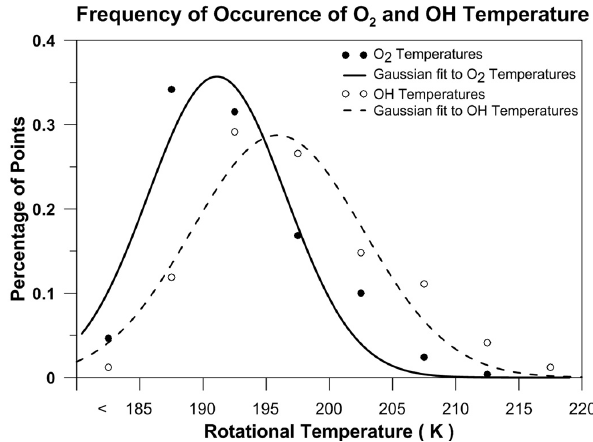
Fig. 2. Frequency of occurrence to O 2 and OH temperatures at Kol- hapur during February–March 2007.